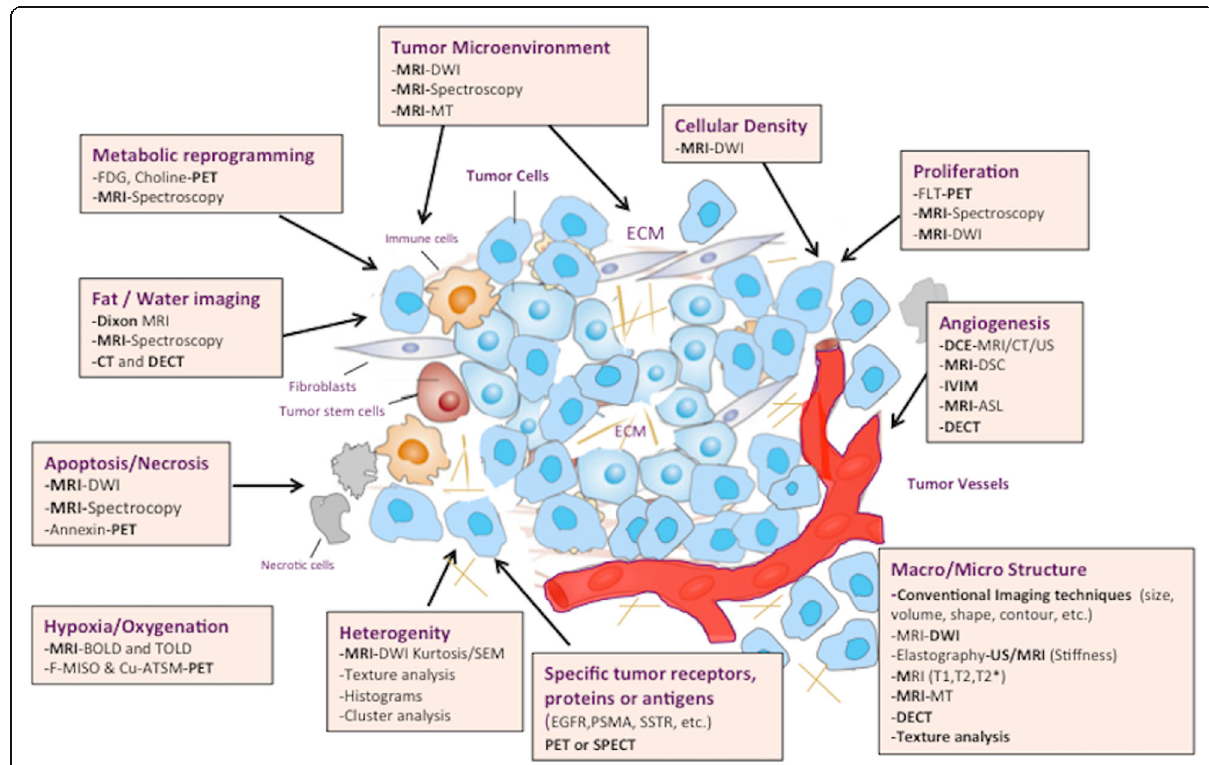
Fig. 1 Main imaging techniques in the evaluation of tumor biology and